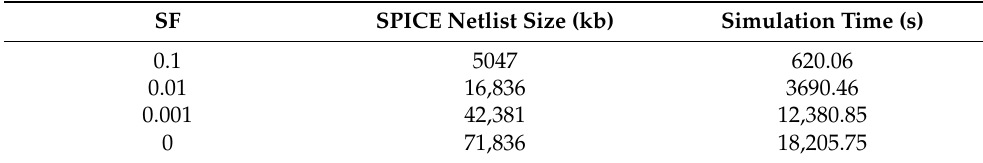
Table 1. Simulation consumption with different